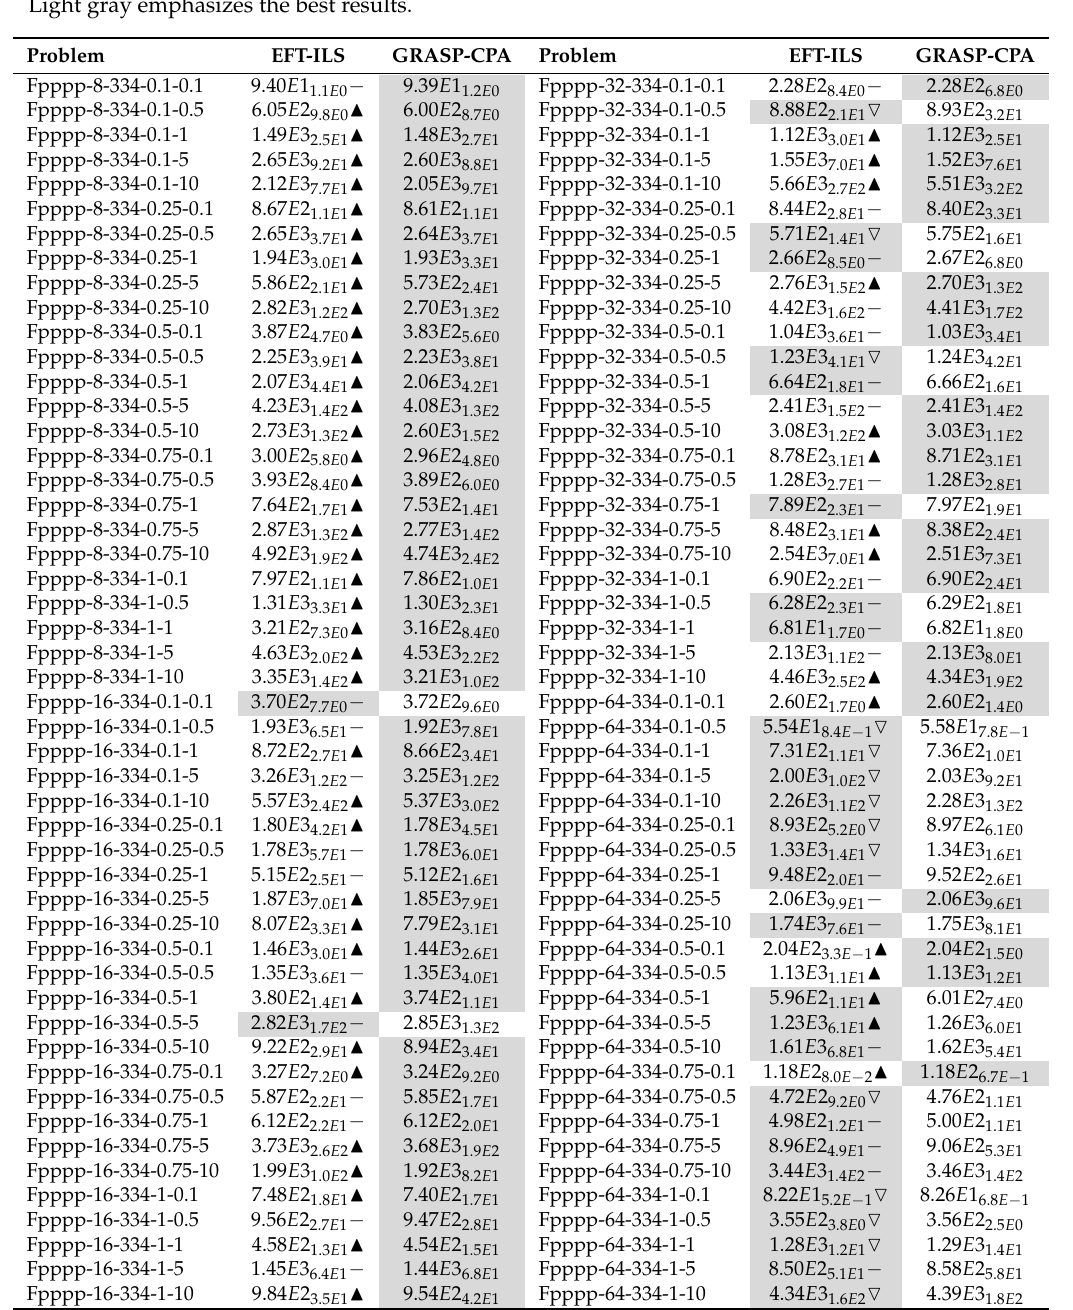
Table 4. Fpppp instances median and IQR of EFT-ILS and GRASP-CPA over 100 independent runs. Light gray emphasizes the best